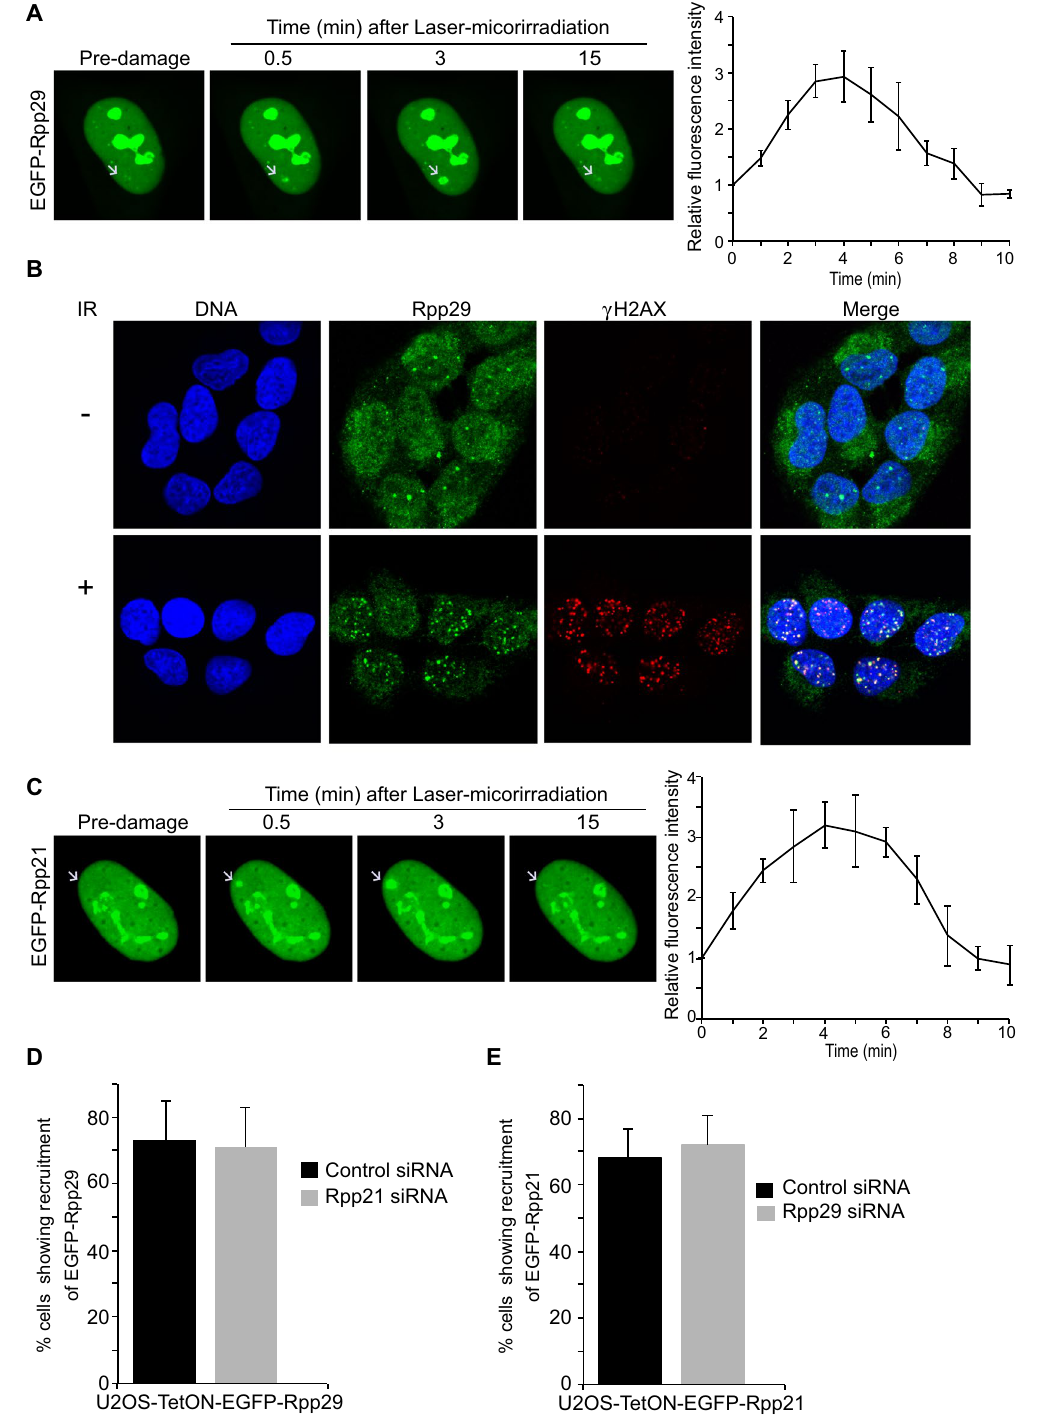
Figure 3. Rpp21 and Rpp29 show rapid and transient recruitment to DNA damage sites. ( A ) Time-lapse images show the localization of EGFP-Rpp29 at the indicated time points after laser micro-irradiation of a single region, marked by a white arrow. Graph (Right) shows fold increase in the relative fluorescence intensity of EGFP-Rpp29 at laser-microirradiated sites. Each measurement is representative of at least 10 cells. Error bars indicate SD. ( B ) Representative images showing IRIF enriched with endogenous Rpp29 protein. U2OS cells were exposed to IR (5 Gy), fixed after 3 min recovery and stained for DNA (blue), Rpp29 (green) and γ H2AX (red). A merged image is seen on the right. Results shown are typical of three independent experiments and represent at least 15 different cells. ( C ) As in ( A ), time-lapse images showing the recruitment of EGFP-Rpp21 to laser microirradiated sites. ( D,E ) Graphs display the percentage of Rpp21 ( D ) and Rpp29 ( E ) deficient cells showing recruitment of EGFP-Rpp29 and EGFP-Rpp21 to damaged sites, respectively, as compared with cells transfected with control siRNA. Error bars represent the SEM from two independent